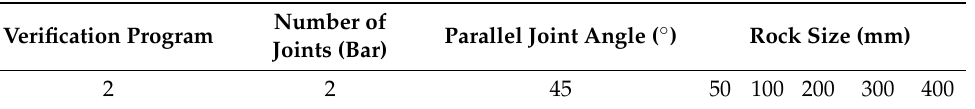
Table 2. Verification program 1.